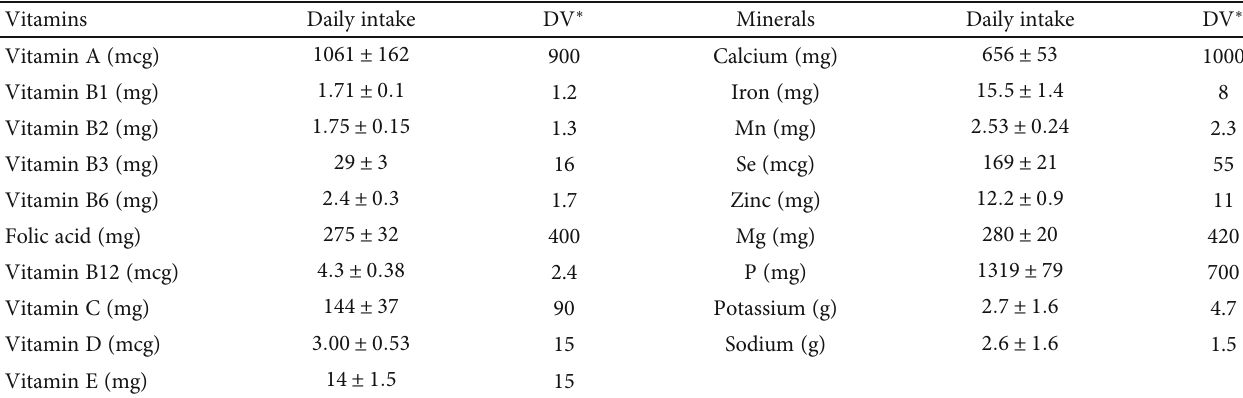
Table 2: Micronutrient daily intake in marathon runners.